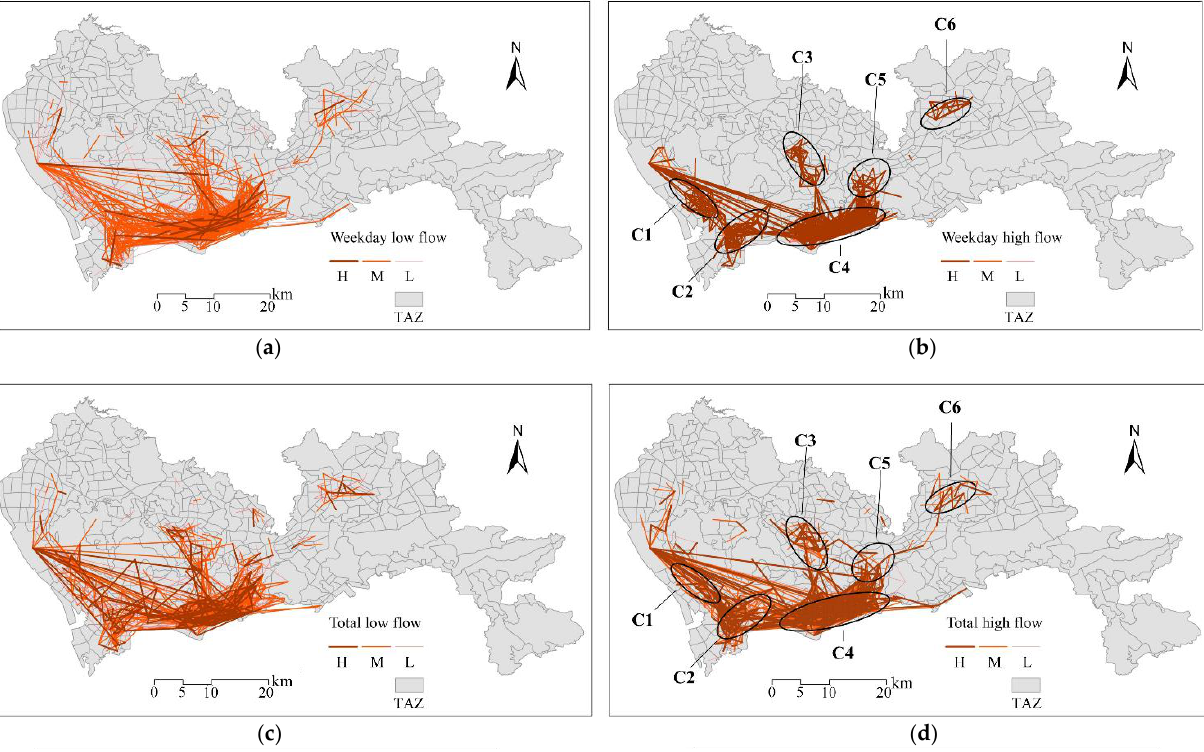
Huaqiang North Business District, Fukuda Port, Dongmen Old Street Business District